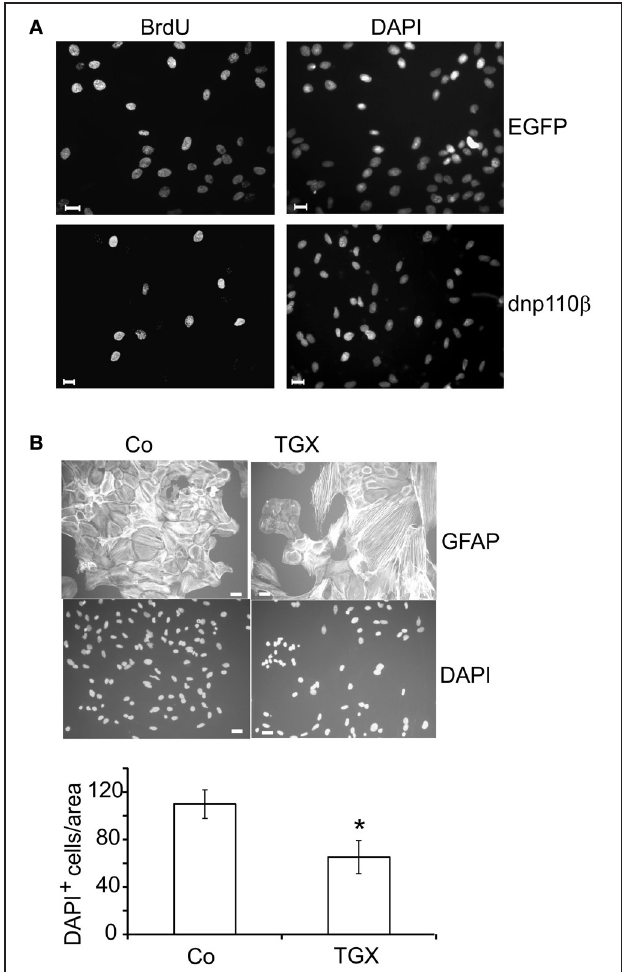
FIGURE 3 | Short- and long-term effects of 110 β inhibition in neocortical astroglial cells. (A) Transfection with dnp110 β (lower panels) decreases nuclear staining of BrdU (left panels). Cells transfected with vector coding for EGFP (upper panels) are shown as controls. DAPI staining shows all nuclei (right panels). (B) TGX-221 (200nM) decreases the total cell number, when applied for 3 days. GFAP staining (upper panels); DAPI staining (lower panels). (B) Quantitation of DAPI staining; means ± CI (0.95); ∗ ∼ p < 0 . 05 compared to controls; n ≥ 12; scale bars ∼ 10 μ m.